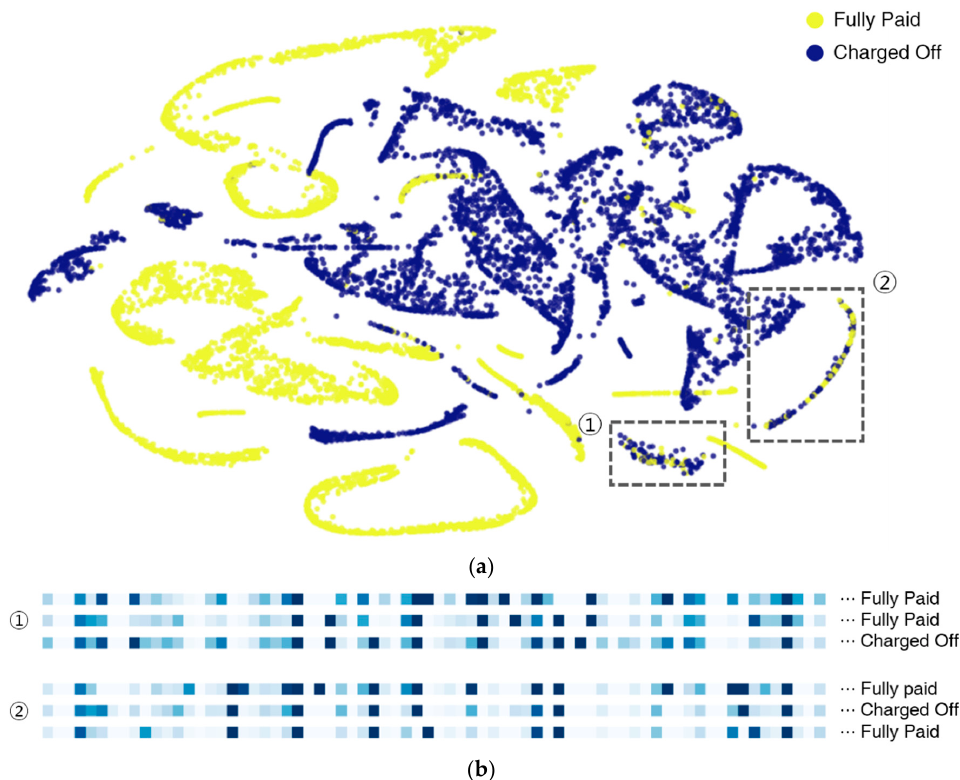
Figure 6. ( a ) 2D projections of the feature vectors using t-SNE. ( b ) Three samples selected at random from two clusters mixed. from two clusters